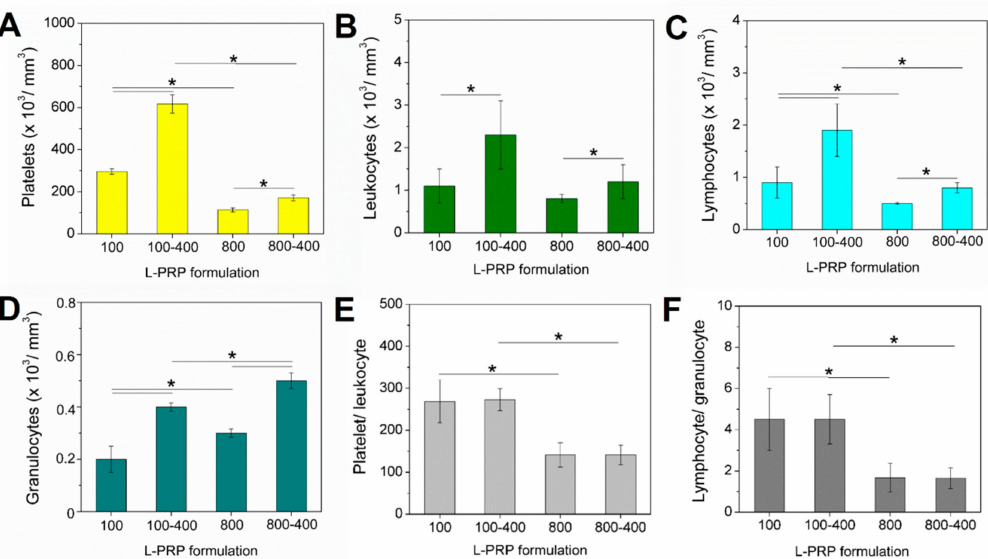
Figure2. Concentrationof( A )platelets, ( B )leukocytes, ( C )lymphocytes, and( D )granulocytes, obtained by measuring each L-PRP in a hematologic analyzer. The calculated ratio of ( E ) platelet / leukocyte and ( F ) lymphocyte / granulocyte. Note: * p < 0.05.